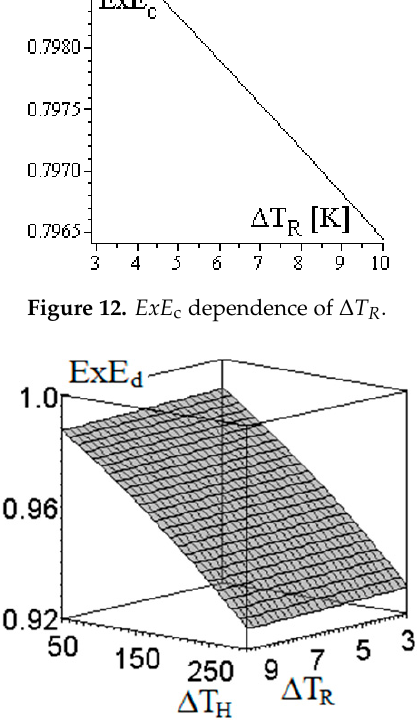
Energies 2018 , 11 , x FOR PEER REVIEW 16 of 22 Figure 13. ExE d dependence of ∆ T H and ∆ T R . Figure 13. ExE d dependence of Δ T H and Δ T R . Figure 13. ExE d dependence of Δ T H and Δ T R . Figure 13. ExE d dependence of Δ T H and Δ T R .